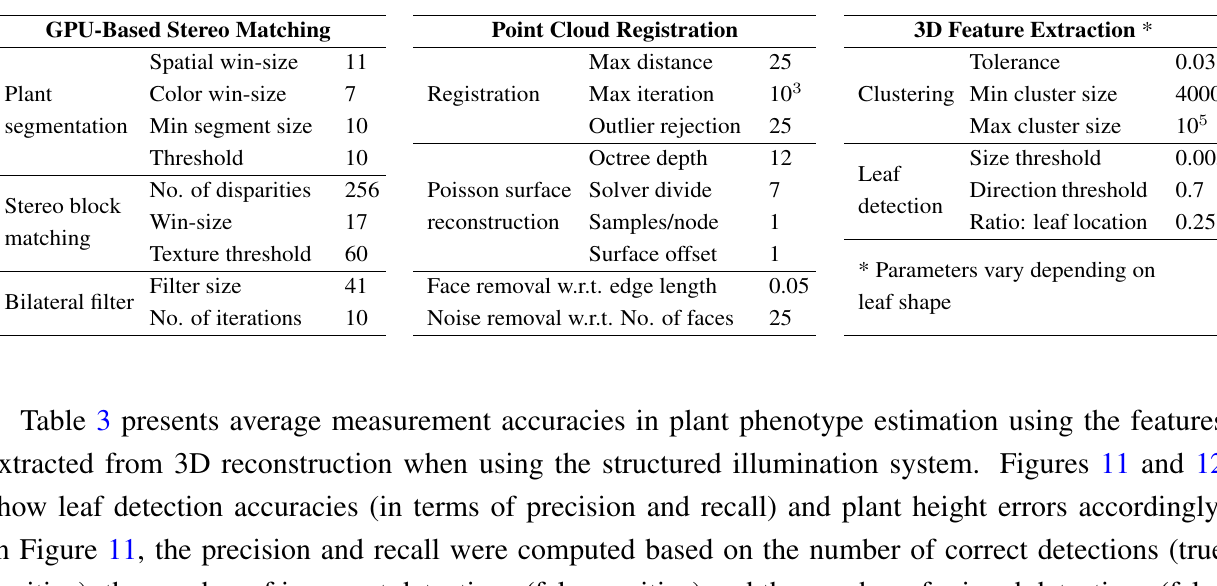
Table 2. Algorithm parameters used for the